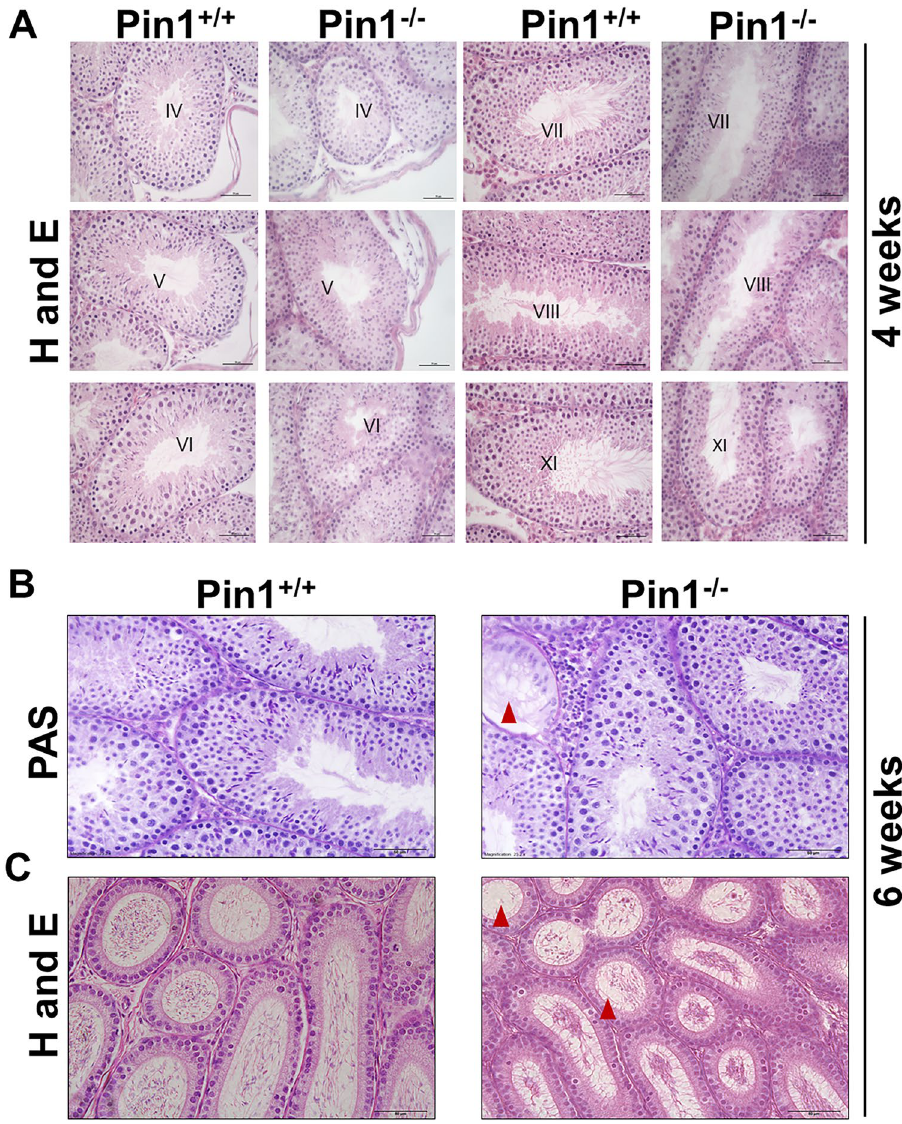
Figure 1. Pin1 ablation causes abnormal seminiferous epithelium and a gradual loss of germ cells. ( A ) The histological structure of seminiferous epithelium stained with hematoxylin and eosin (H and E) in Pin1 + / + and Pin1 − / − mice at 4 weeks of age (scale bar = 50 µ M). ( B ) Periodic acid–Schiff (PAS) stain of histological sections from 6-week-old Pin1 + / + and Pin1 − / − mice. Arrowheads indicate abnormal phenotypes of the seminiferous epithelium including vacuolation. ( C ) H and E-stained sections of the epididymides of 6-week-old mice (scale bar = 50 µ